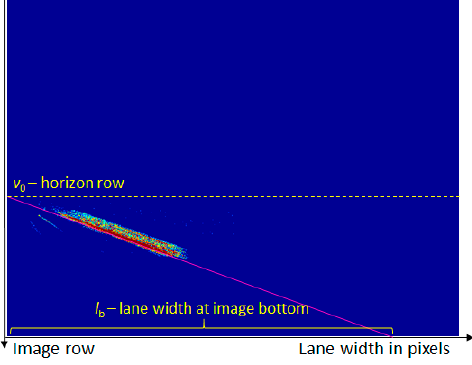
Figure 10. Fitting a line to the voting matrix, to establish the linear variation of lane width with the image row. The intersection of the line with the zero column is the horizon row, and the intersection with the zero row is the lane width at the bottom of the image.